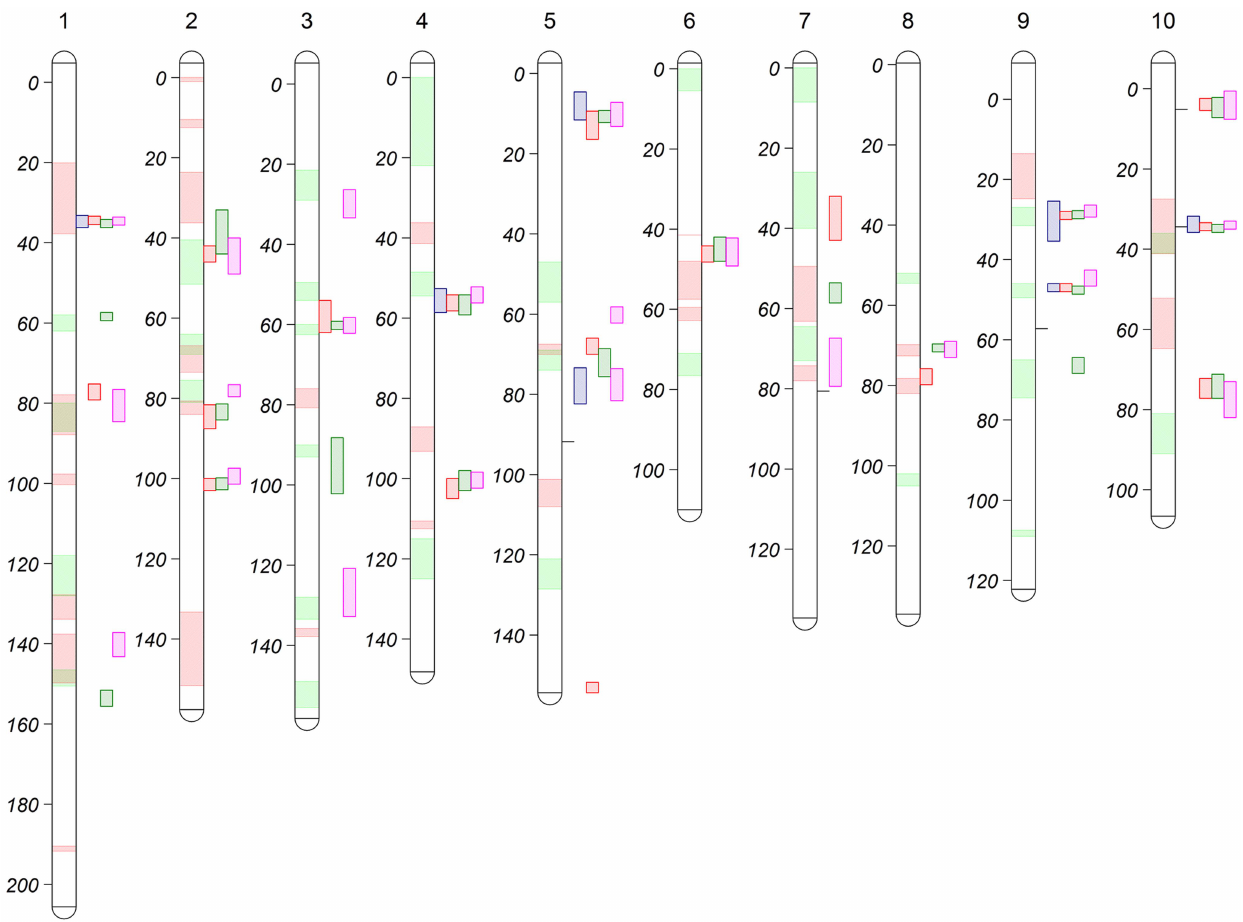
Figure 1. NAM joint-linkage QTL analysis for HR-related traits (LES, HTR, SWR and DTAR) across all the 10 maize chromosomes/ linkage groups. Units on vertical bars are in centi-Morgan (cM) genetic distance. Colored bars on right side of chromosome bar indicate the HR- related trait QTL support intervals: purple- DTAR; red-HTR; green-LES pink-SWR, while green and red segments inside chromosome bars correspond to SLB and NLB resistance QTL support intervals, respectively (Derived from KUMP et al. [34]; POLAND et al. [35]). Horizontal lines on the right side of chromosomes 5, 7,9,10 indicate significant SNP hits for HR-related traits from a previous study (OLUKOLU et al. [27]).